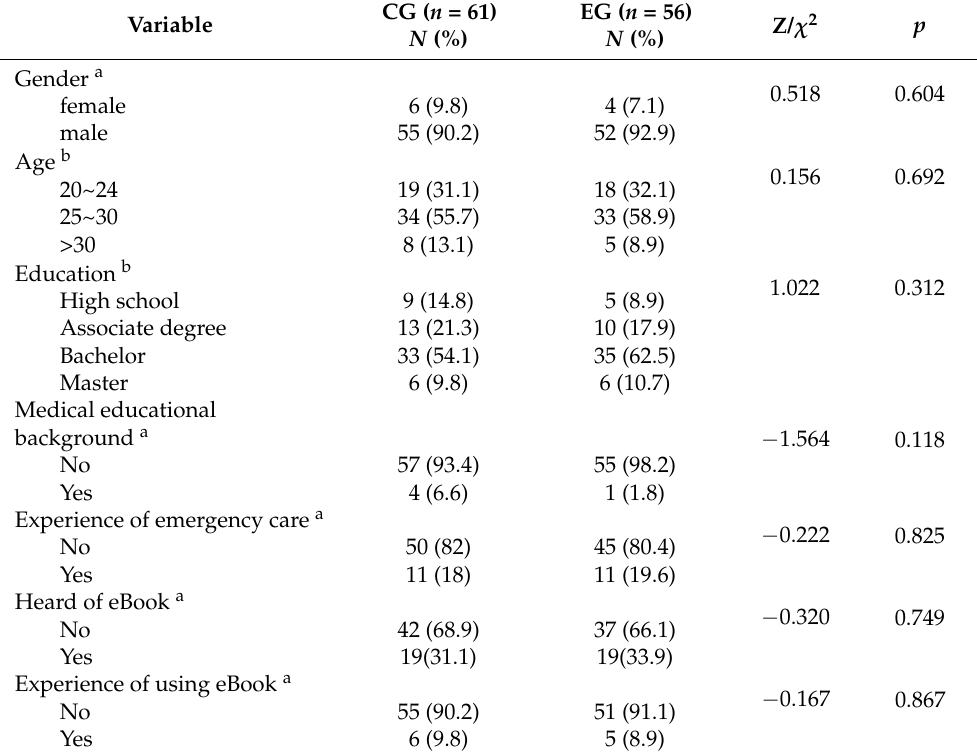
Table 1. Demographic characteristics (N = 117).